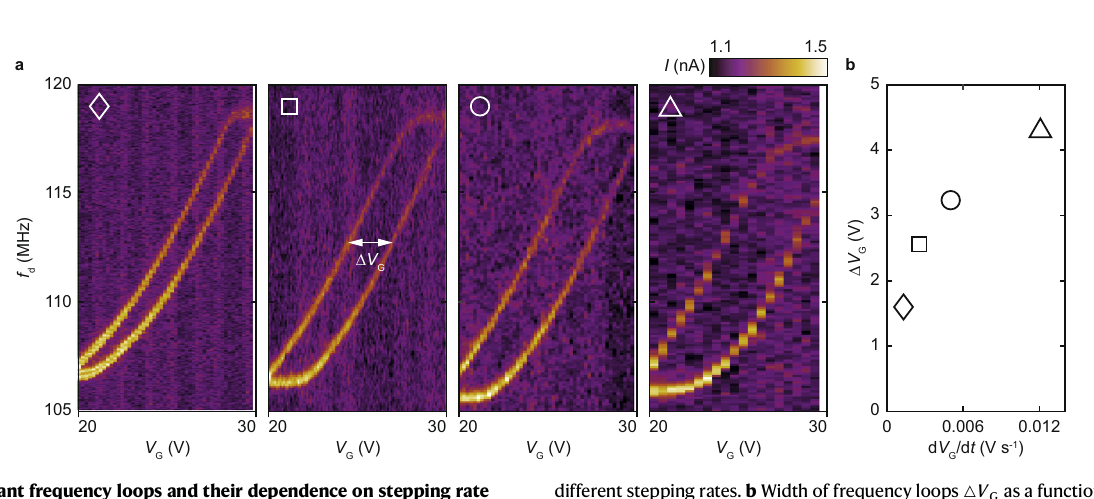
different stepping rates. b Width of frequencyloops 4 V G as a function of d V G = d t . Marker shape identi fi es the data set in a from which 4 V G is